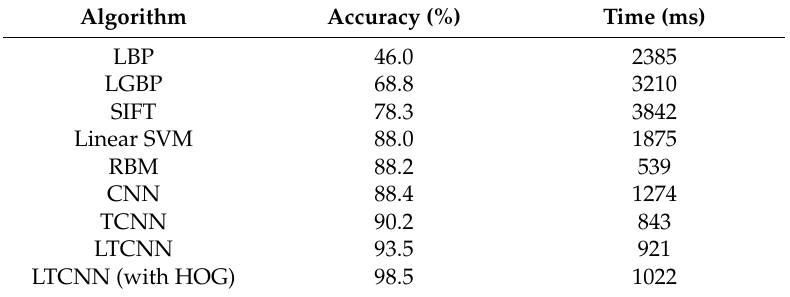
Table 1. Performance comparison of vehicle-model recognition with prestigious